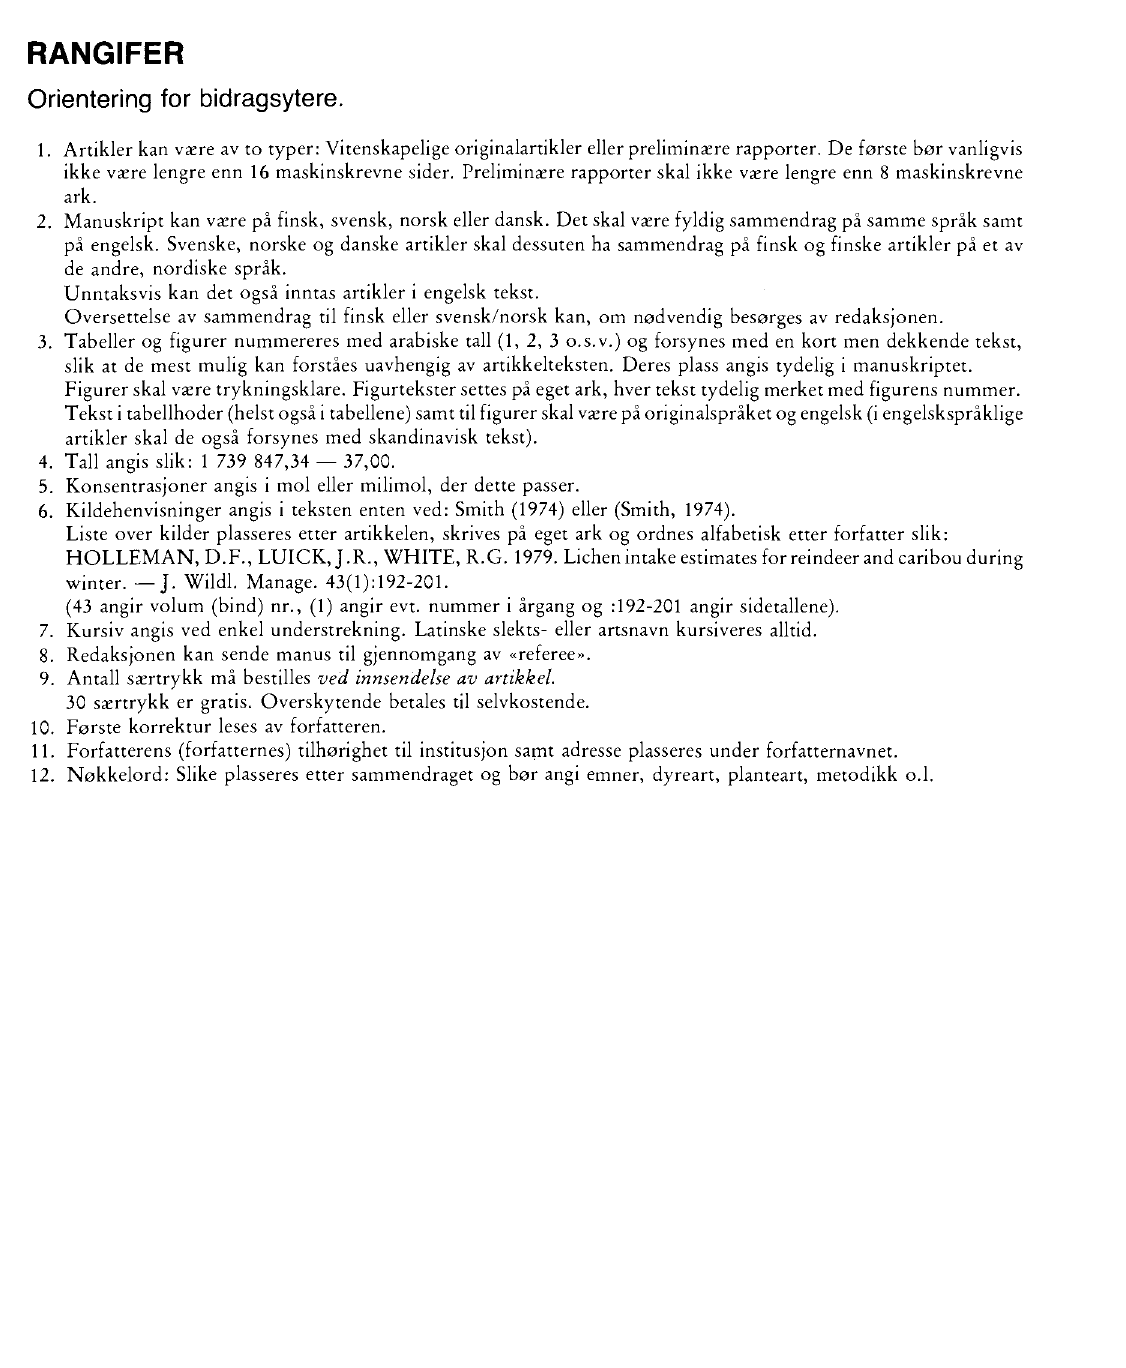
3. Tabeller og figurer nummereres med arabiske tall (1, 2, 3 o.s.v.) og forsynes med en kort men dekkende tekst, slik at de mest mulig kan forståes uavhengig av artikkelteksten. Deres plass angis tydelig i manuskriptet. Figurer skal være trykningsklare. Figurtekster settes på eget ark, hver tekst tydelig merket med figurens nummer. Tekst i tabellhoder (helst også i tabellene) samt til figurer skal være på originalspråket og engelsk (i engelskspråklige artikler skal de også forsynes med skandinavisk tekst). 4. Tall angis slik: 1 739 847,34 —